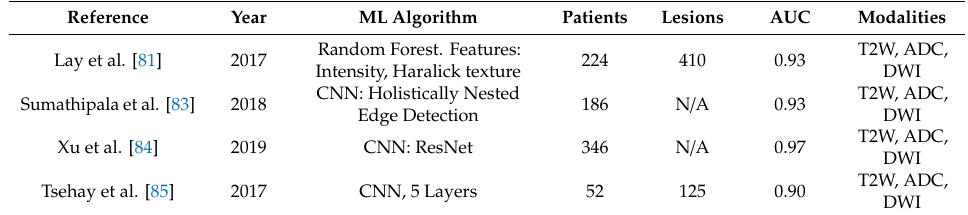
Figure 4. Prostate lesion detection using machine learning methods. The computer takes multiparametric magnetic resonance imaging images of the prostate as inputs and applies the developed machine learning algorithm to correctly localize lesions in the prostate. Table 2. Machine learning techniques applied to prostate lesion detection.